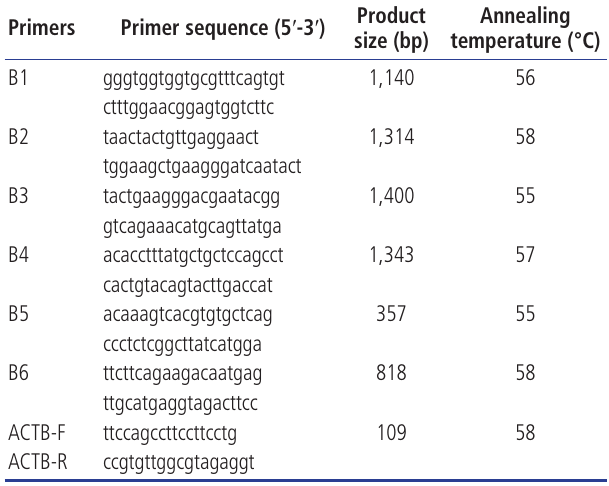
Table 1. Primers used for LIN28B gene